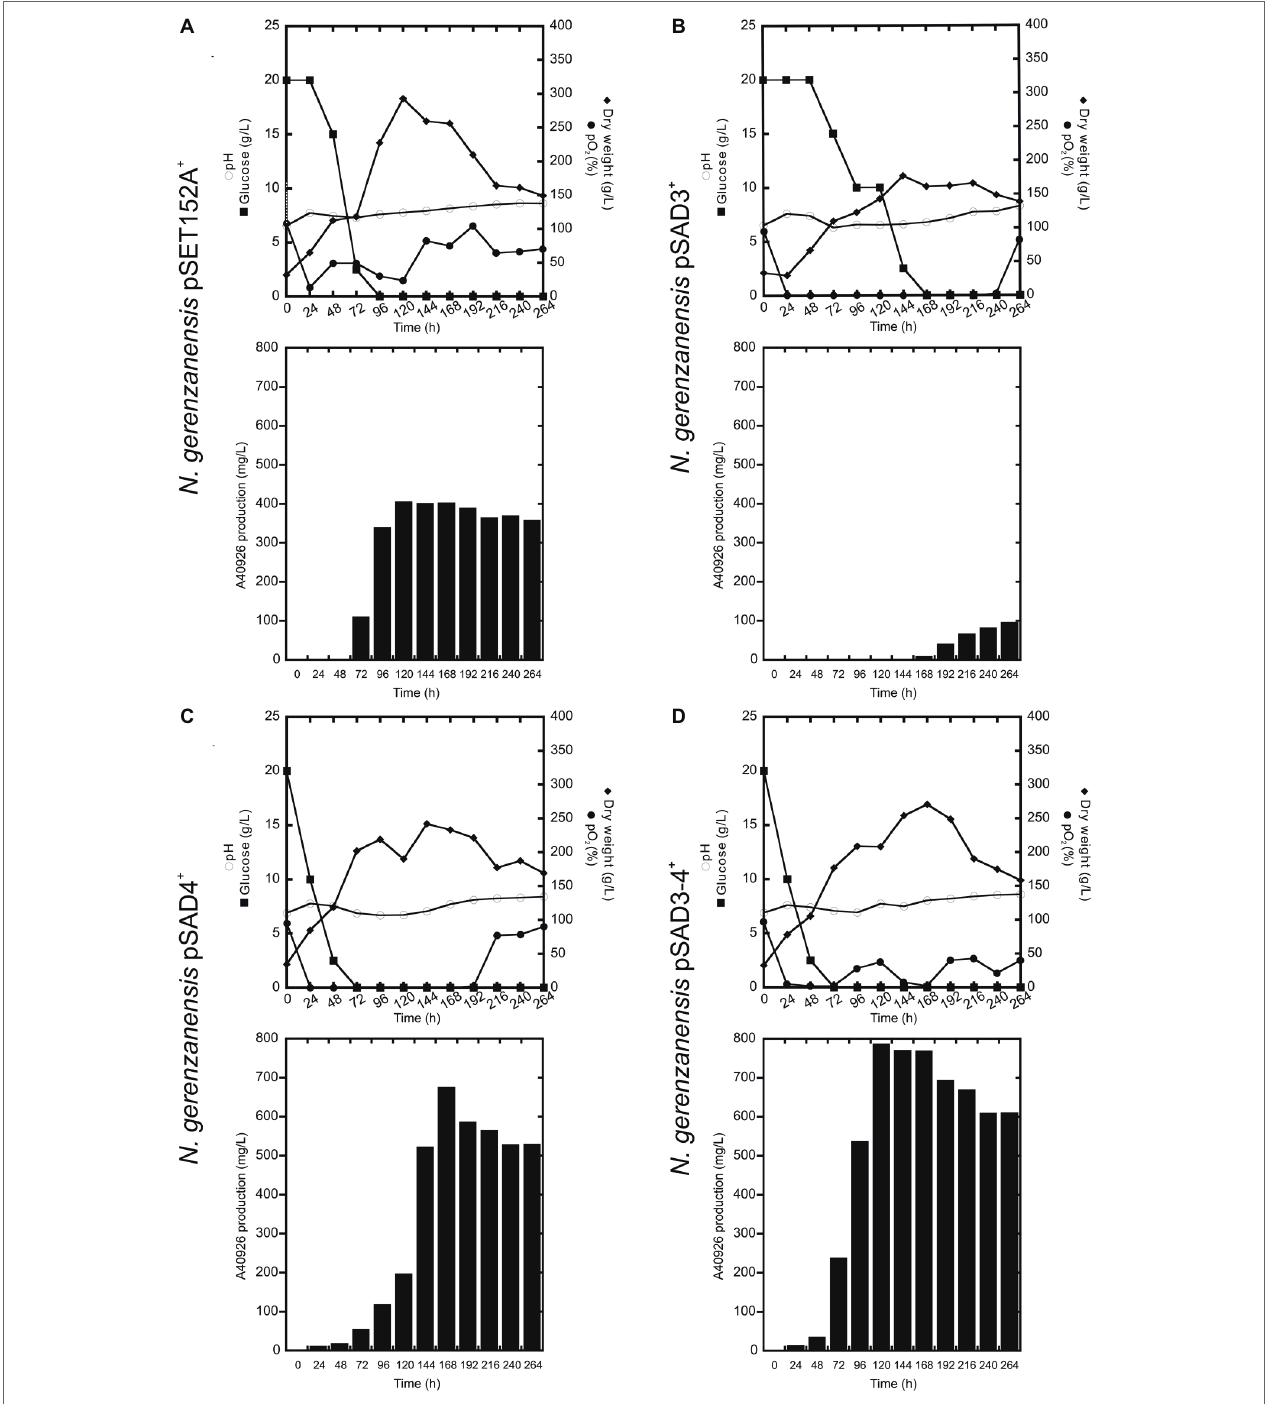
FIGURE 5 | Time courses of N. gerenzanensis pSET152A + (A) and recombinant strains, overexpressing dbv3 (B) , dbv4 (C) and co-expressing both genes (D) cultivated in 2 l FM2 industrial medium in a 3 l fermenter. Glucose consumption (filled rectangles), biomass accumulation (filled rhombi), pH (circles), O 2 level (filled circles), and A40926 production were monitored every 24